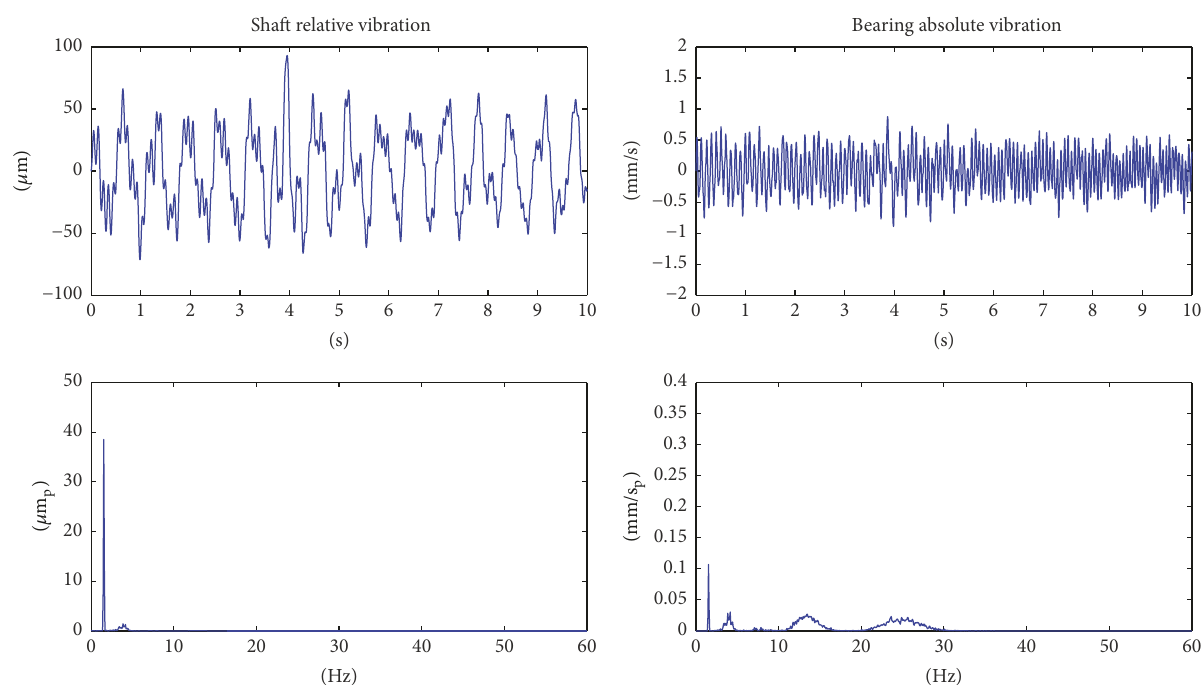
Figure 18: Simulated shaft relative and bearing absolute vibrations at 𝑋 direction of the lower journal bearing, when generator rotor had an unbalance